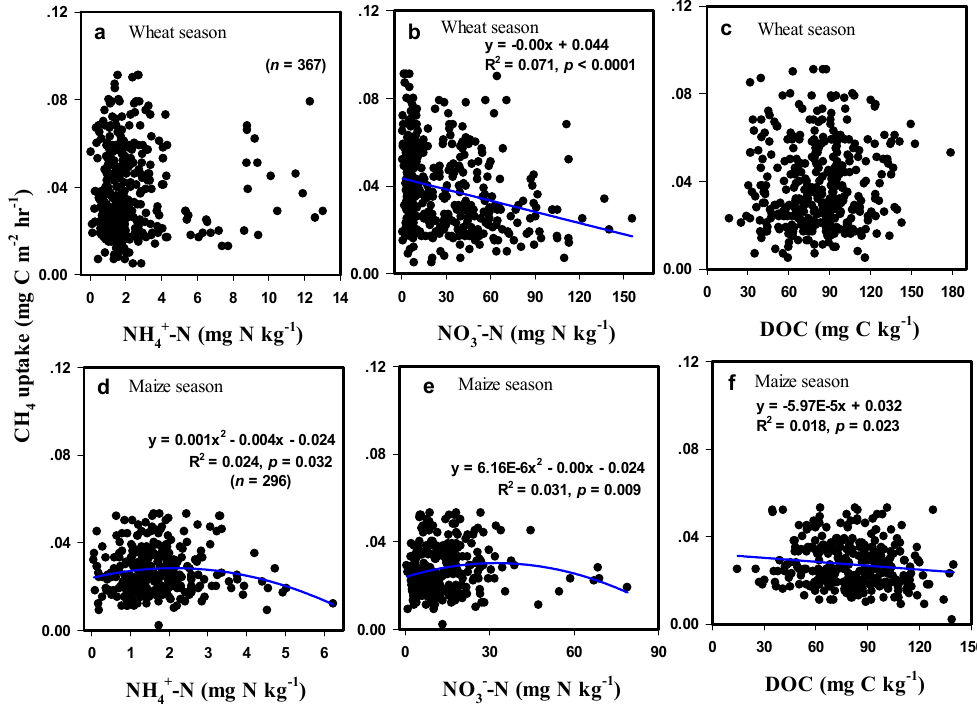
Figure 7. Relationships between CH 4 uptake and NH 4 + -N, NO 3 − -N, and DOC content and soil in the wheat season ( a – c ) and in the maize season ( d – f ) for the wheat and the maize seasons across the four treatments over the two-year period from 2016 – 2018.